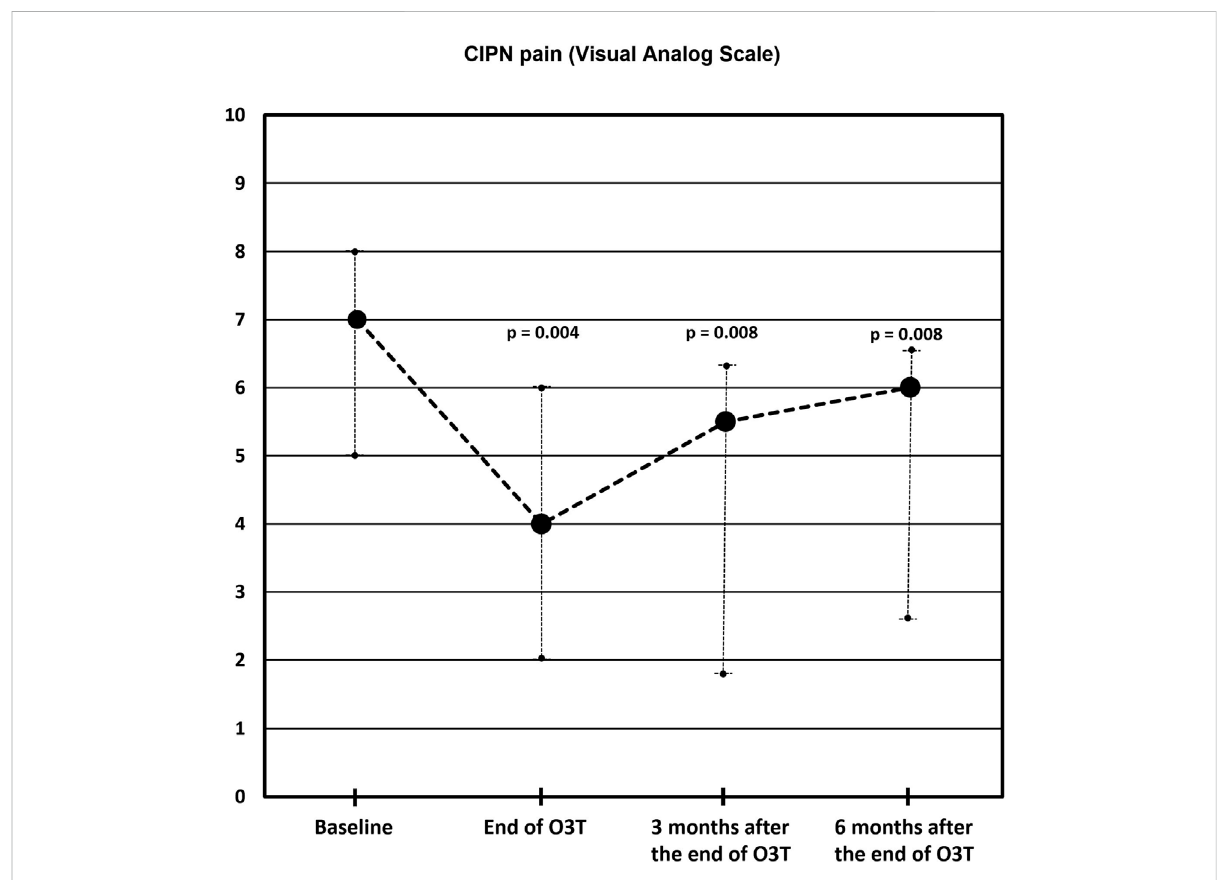
FIGURE 1 Chemotherapy-induced peripheral neuropathy (CIPN) pain according to the Visual Analog Scale (VAS). Compared to the baseline value, the median VAS pain score was signi fi cantly lower at the end of O 3 T ( p = 0.004), 3 months ( p = 0.008), and 6 months ( p = 0.008) after the end of O 3 T (exact signi fi cance Wilcoxon Rank